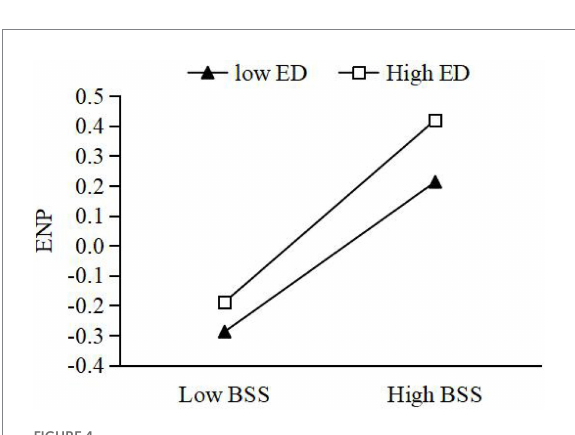
FIGURE 4 Moderating effect of environmental dynamism (ED) between boundary-spanning search (BSS) and economic performance (ENP).